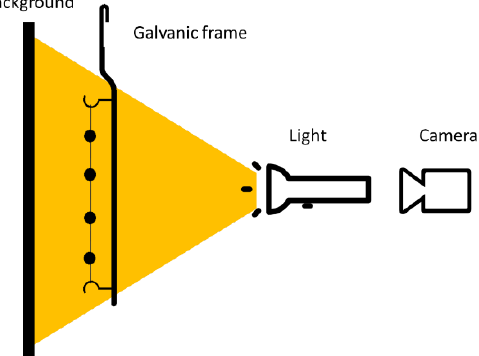
Figure 4. Frontal light with black uniform background setup.